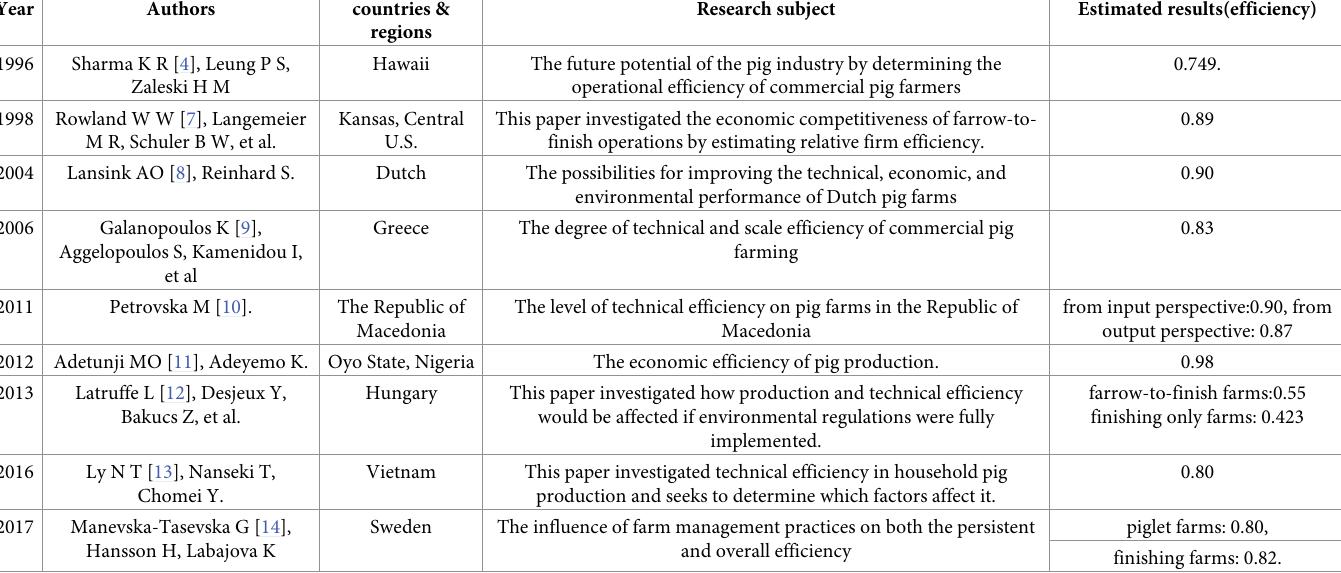
Table 1. Existing literature on research pig